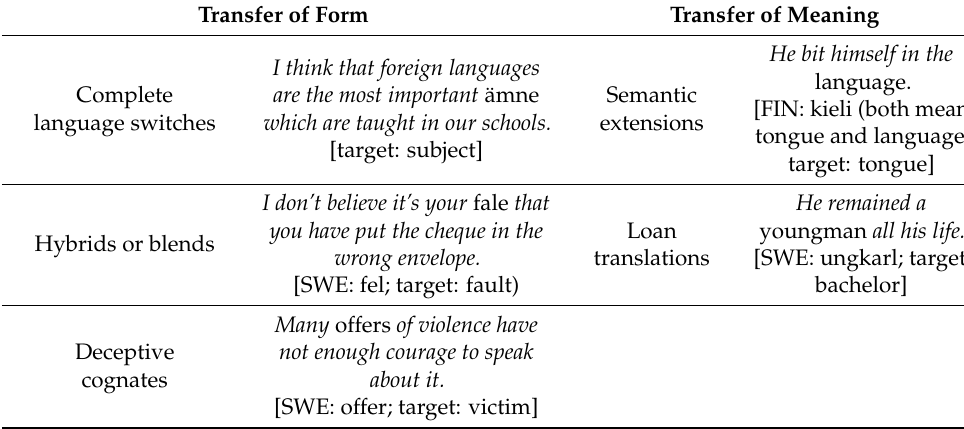
Table 1. Examples of lexical CLI taken from Ringbom